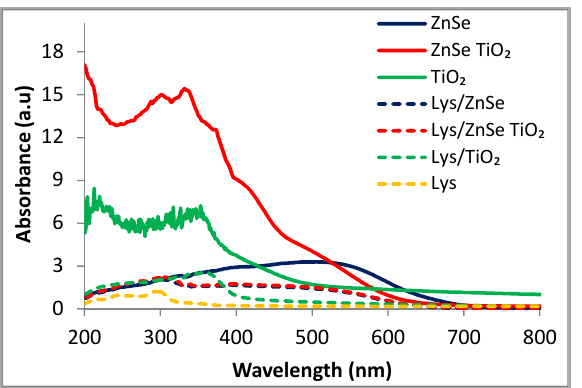
Figure 16. Comparative UV–visible spectra of ZnSe, ZnSe-TiO 2 and TiO 2 powders before and after lysozyme loading.